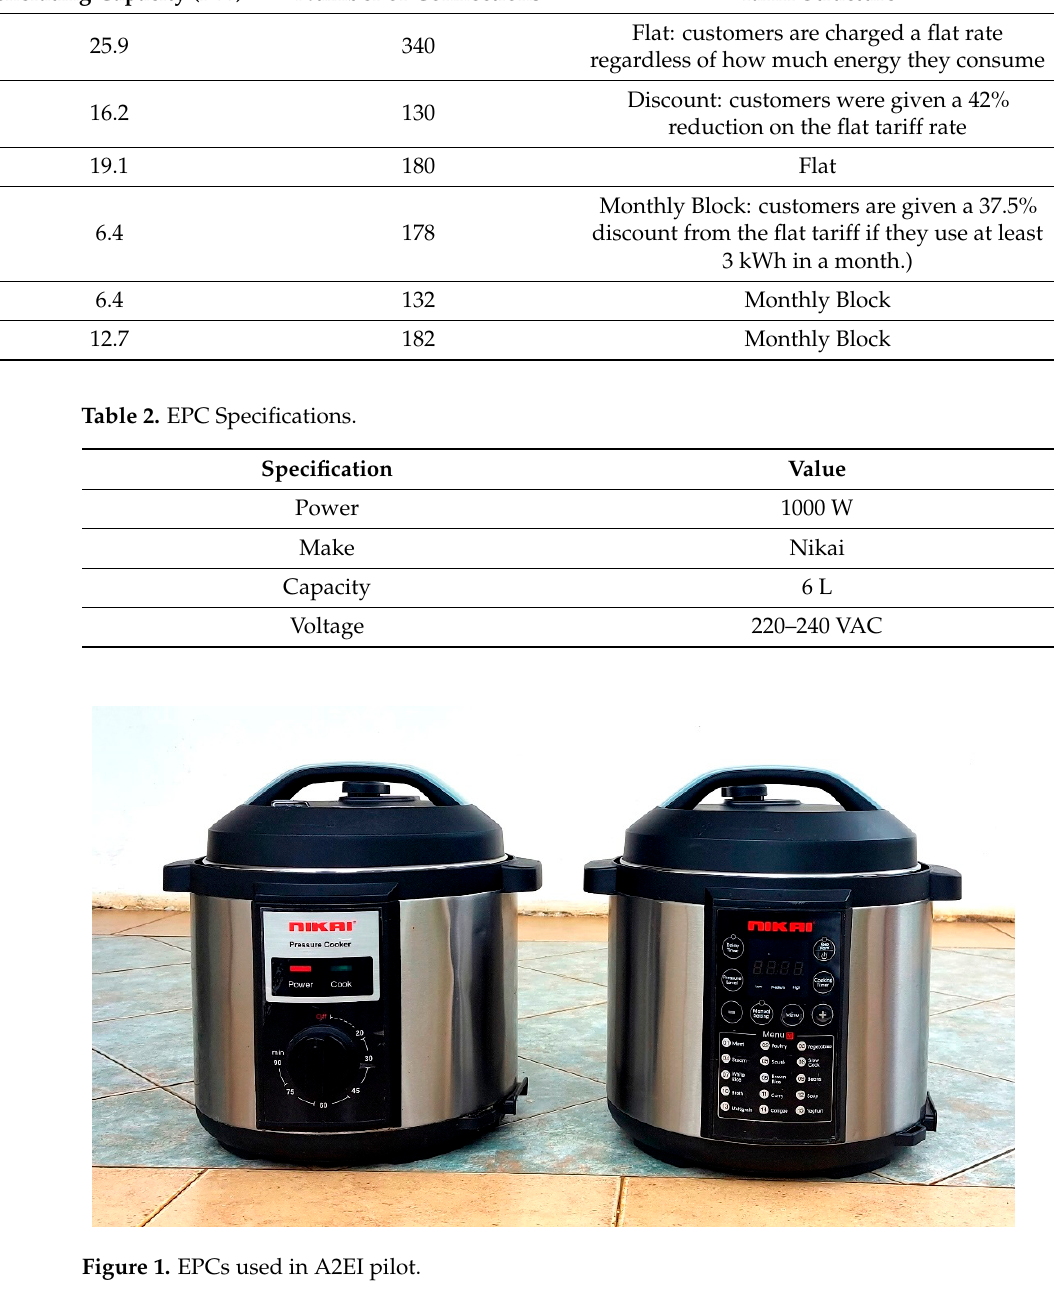
Table 1. Mini-grid sites in A2EI pilot.